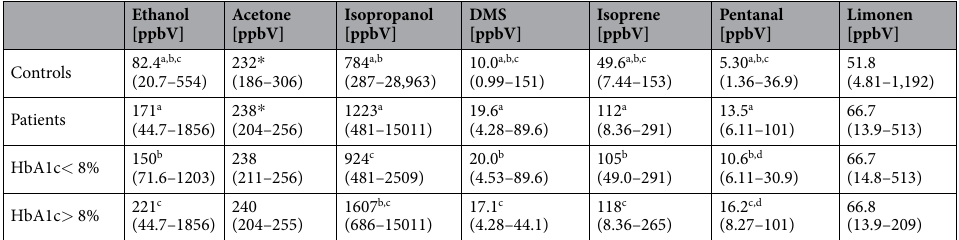
Table 1. Exhaled amounts of selected alveolar VOCs in the study population. Data is given as median and range. Superscripts denote significantly different concentrations of the respective analytes between identically labelled groups. DMS, dimethylsulfide. a controls vs patients: p < 0.001 for ethanol, DMS, isoprene, and pentanal, p = 0.002 for isopropanol; b controls vs patients with good metabolic control (HbA 1c < 8%): p < 0.001 for ethanol, DMS, isoprene, and pentanal; c controls vs patients with poor metabolic control (HbA 1c > 8%): p < 0.001 for ethanol, isopropanol, isoprene, and pentanal, p = 0.03 for DMS; d patiens with poor vs those with good metabolic control: p < 0.001 for isopropanol and p = 0.012 for